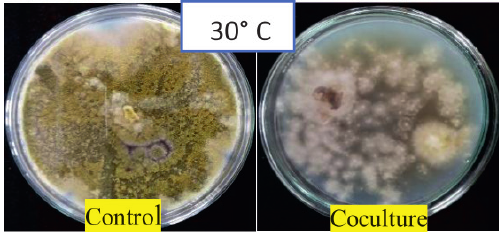
Fig. 11. Highest antagonism of A. giganteus observed at an incubation temperature of 30°C showing stunted growth of pathogenic A.